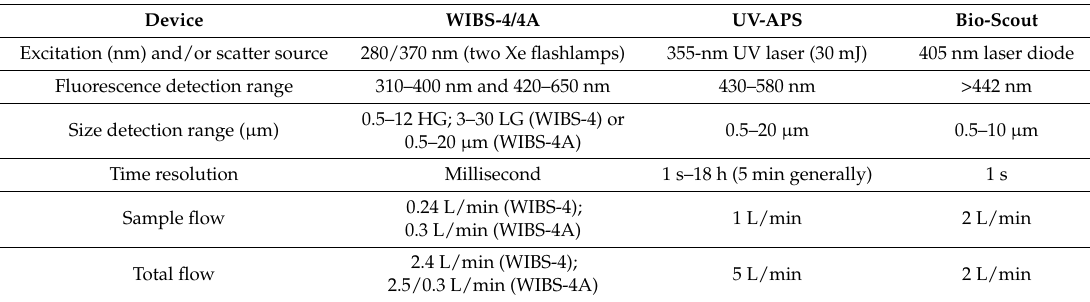
Table 5. Specifications of the online real-time